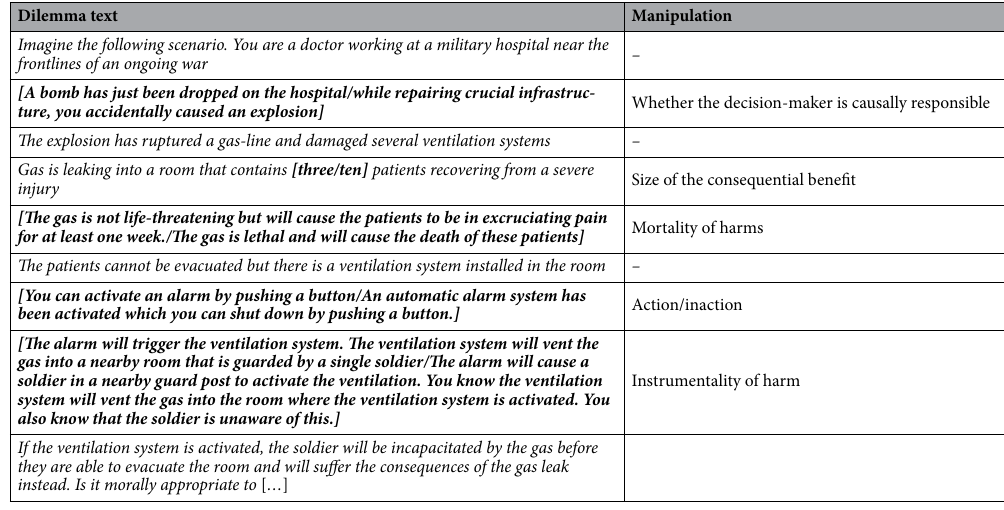
Table 1. Overview of the dilemma and the included dilemma